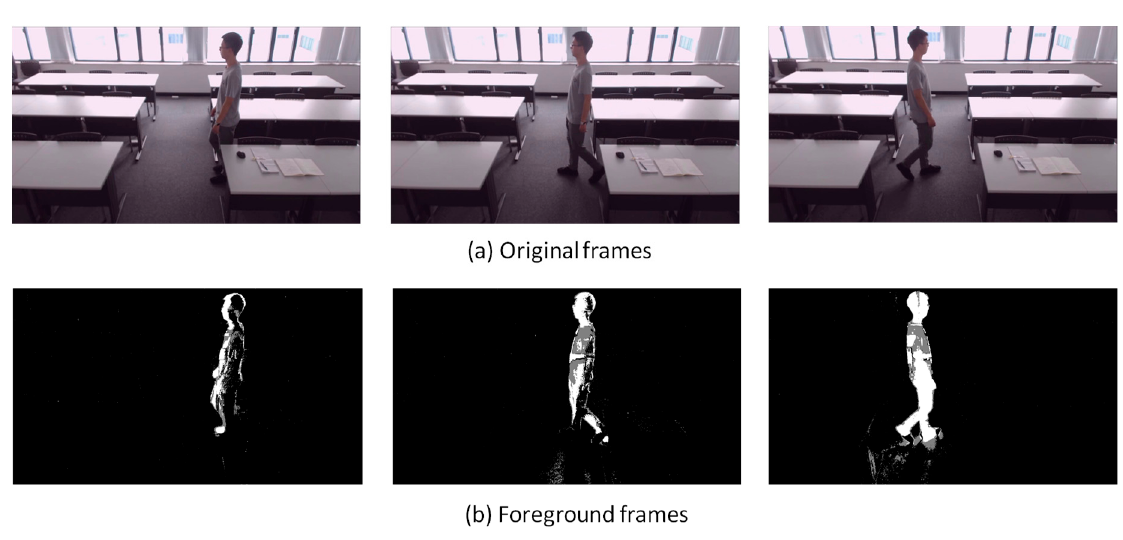
Figure 9. Walking (0.9 m/s)—sample images.